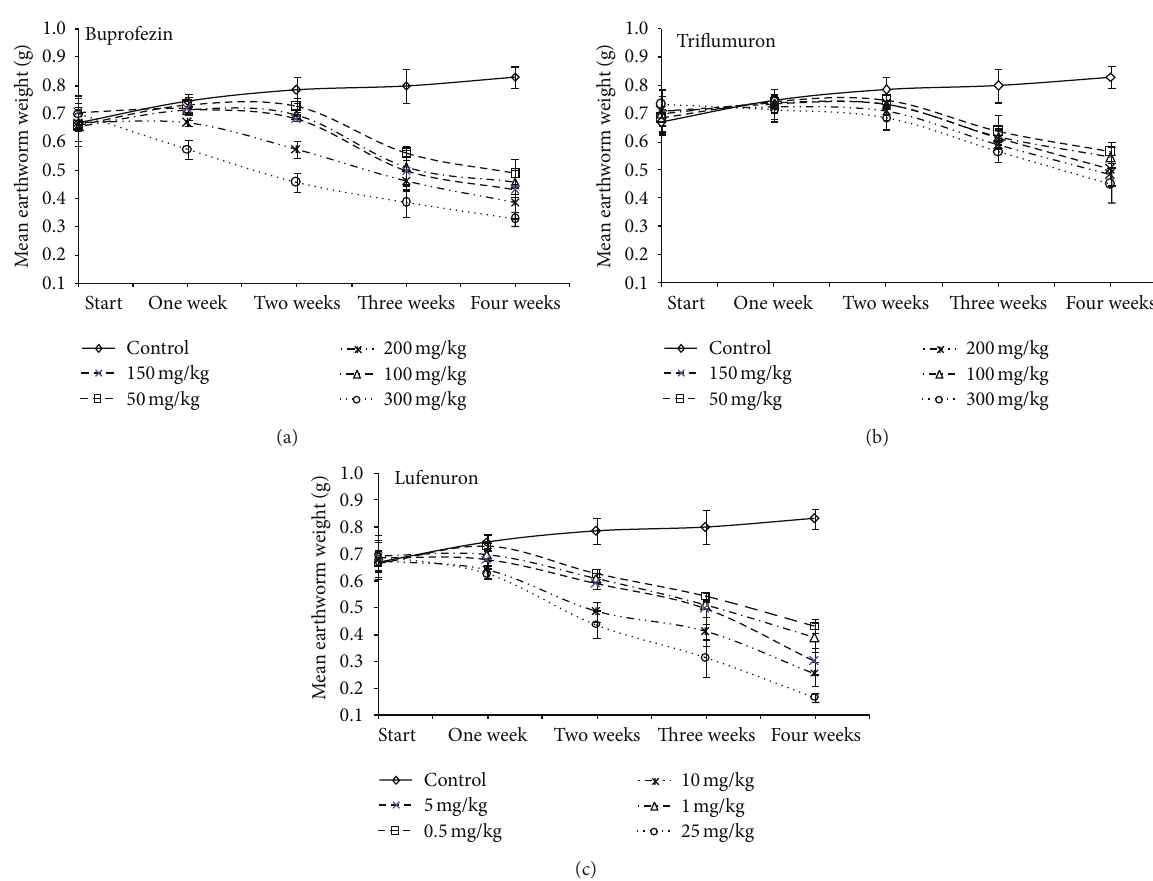
Figure 1: Mean weight ± SD of earthworms A. caliginosa in artificial soil treated with buprofezin, triflumuron, and lufenuron at different application rates in the laboratory. Growth weight measured when experiment started and 1, 2, 3, and 4 weeks after treatment.